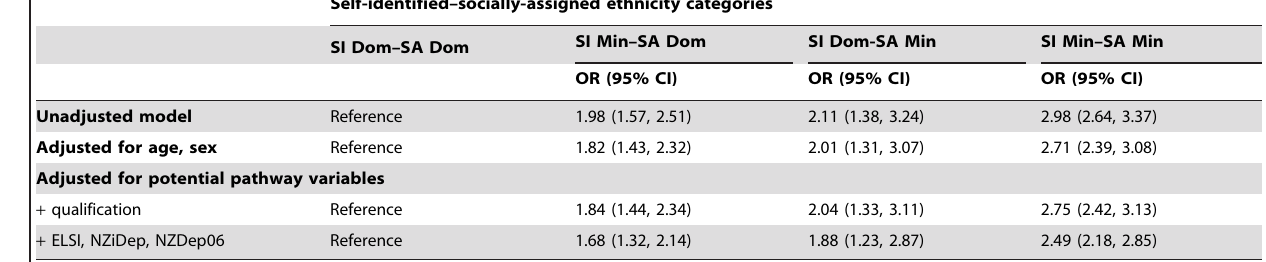
Table 5. Odds of reporting ever experiencing racism for the self-identified–socially-assigned ethnicity categories.